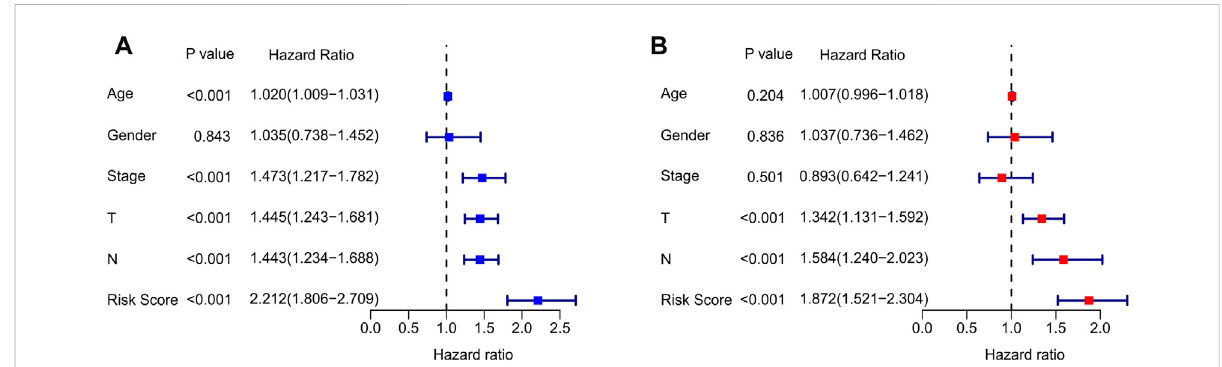
FIGURE 3 Independentprognosisanalysisofclinicalcharacteristicsandriskscore. (A) Univariate Coxregressionanalysis showedtheassociationbetween the overall survival rate and clinical characteristics include age, gender, stage, T, N, and the cuproptosis-related lncRNAs prognostic signature risk scores. (B) MultivariateCoxregressionanalysisdemonstratedthatT,N,andriskscoreareindependentprognosticindicatorforoverallsurvivalrateof CM patients.